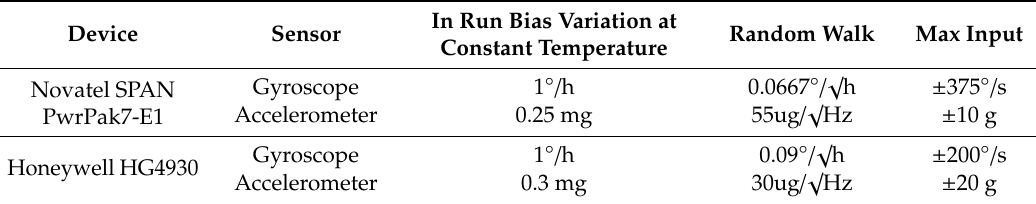
Table 2. Characteristics of the gyroscopes and accelerometers from the Novatel Span Pwrpak7-e1 and the Honeywell